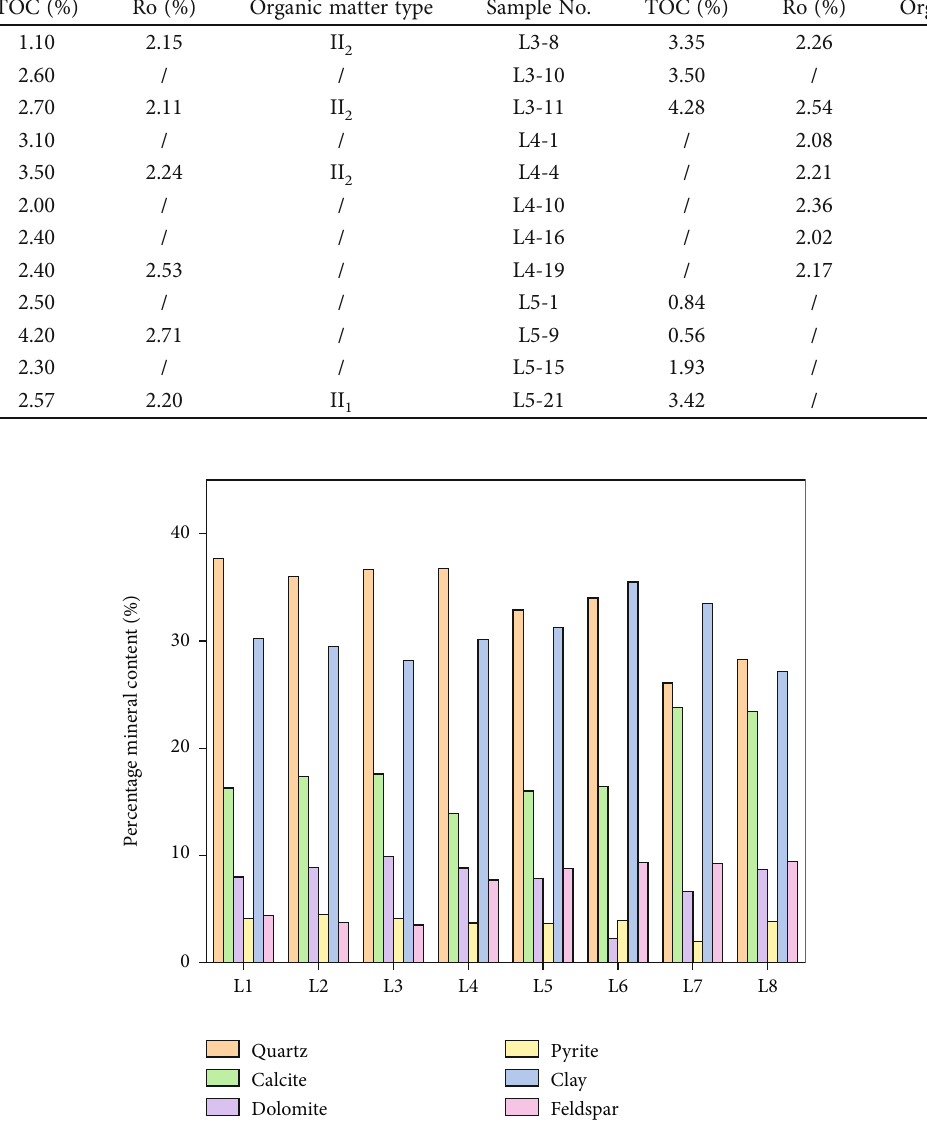
Figure 4: Histogram showing the content distribution of the LF minerals in wells in the study